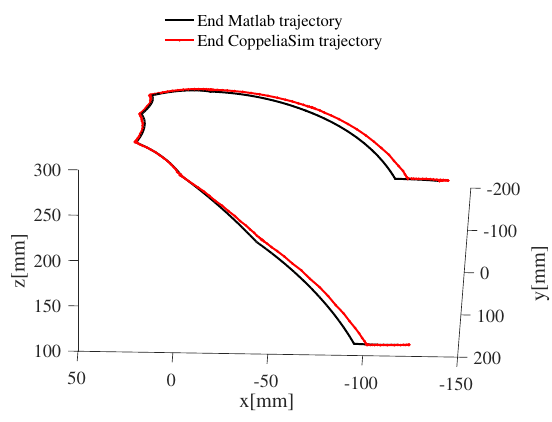
Figure 11. The trajectory of the